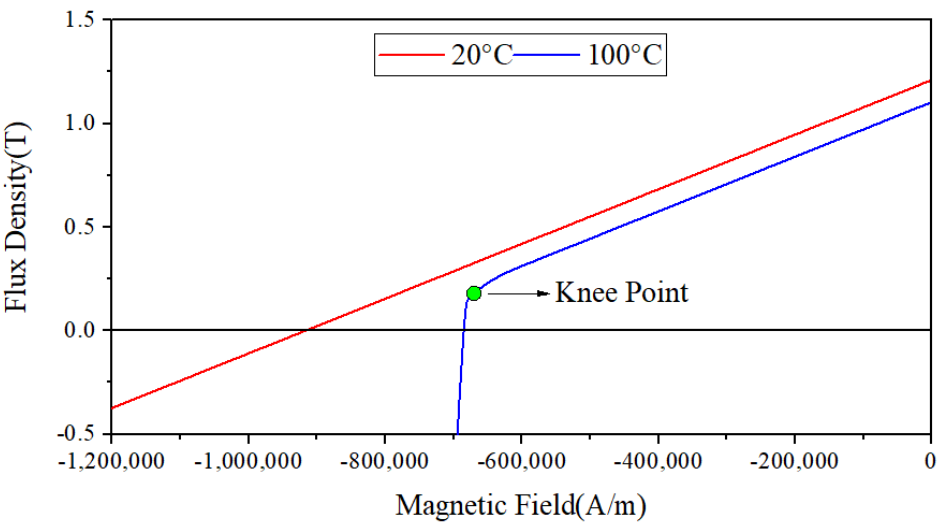
Figure 10. Demagnetization curve of NdFeB 35H under 20 ◦ C and 100 ◦ C.